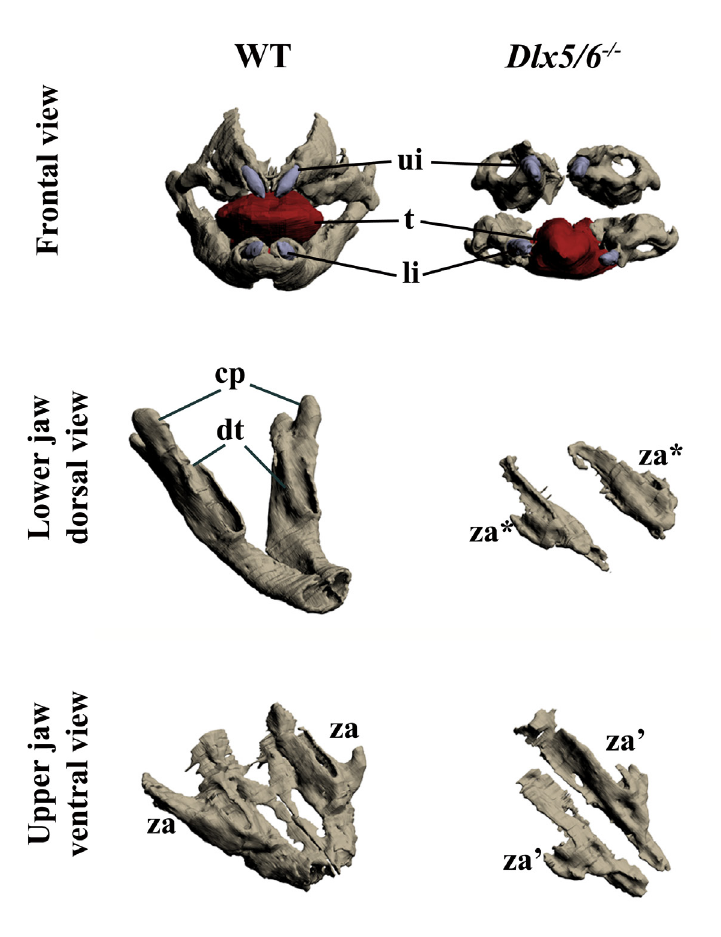
Figure 1. Three-dimensional reconstruction of the dentary and maxillary bones of 18.5dpc wild type and Dlx5/6 -/- mouse embryos. Upper row: Frontal view of WT and Dlx5/6 -/- oral apparatus. Skeletal elements are grey, the tongue is red and incisors are violet. Middle row: Dorsal view of the dentary bone of WT and Dlx5/6 -/- 18.5dpc mice. Lower row: Ventral view of the maxillary components of WT and Dlx5/6 -/- 18.5dpc mice. Note that the inactivation of Dlx5/6 results in the transformation of both lower and upper jaw skeletal elements into new structures which appear more similar to each other than to their WT counterpart. cp, coronoid processes; dt, dentary bone; li, lower incisor; t, tongue; ui, upper incisor; za, zygomatic arch; za*, zygomatic arch-like structure deriving from lower jaw transformation; za’, zygomatic arch- like structure deriving from upper jaw